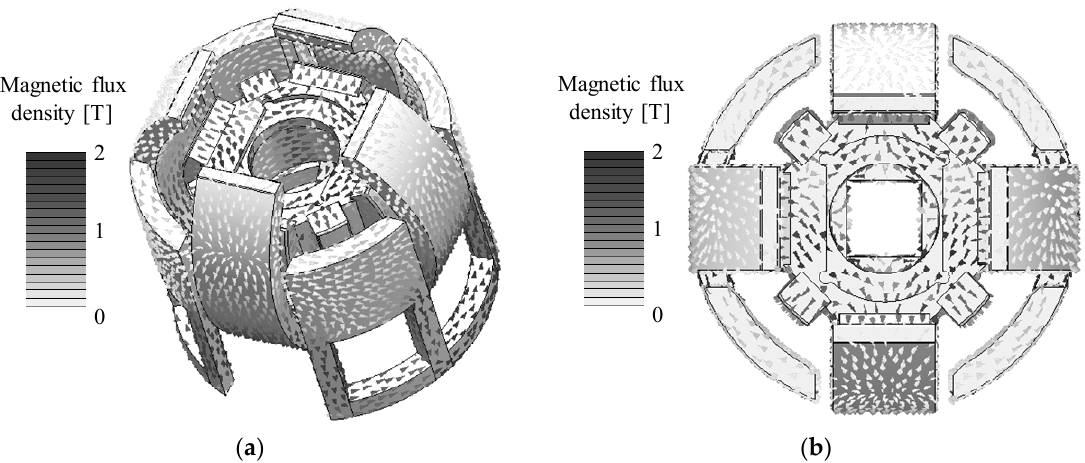
Figure 13. Calculated magnetic flux density distribution. ( a ) Whole view; ( b ) Top view. Sensors 2020 , 20 , x FOR PEER REVIEW